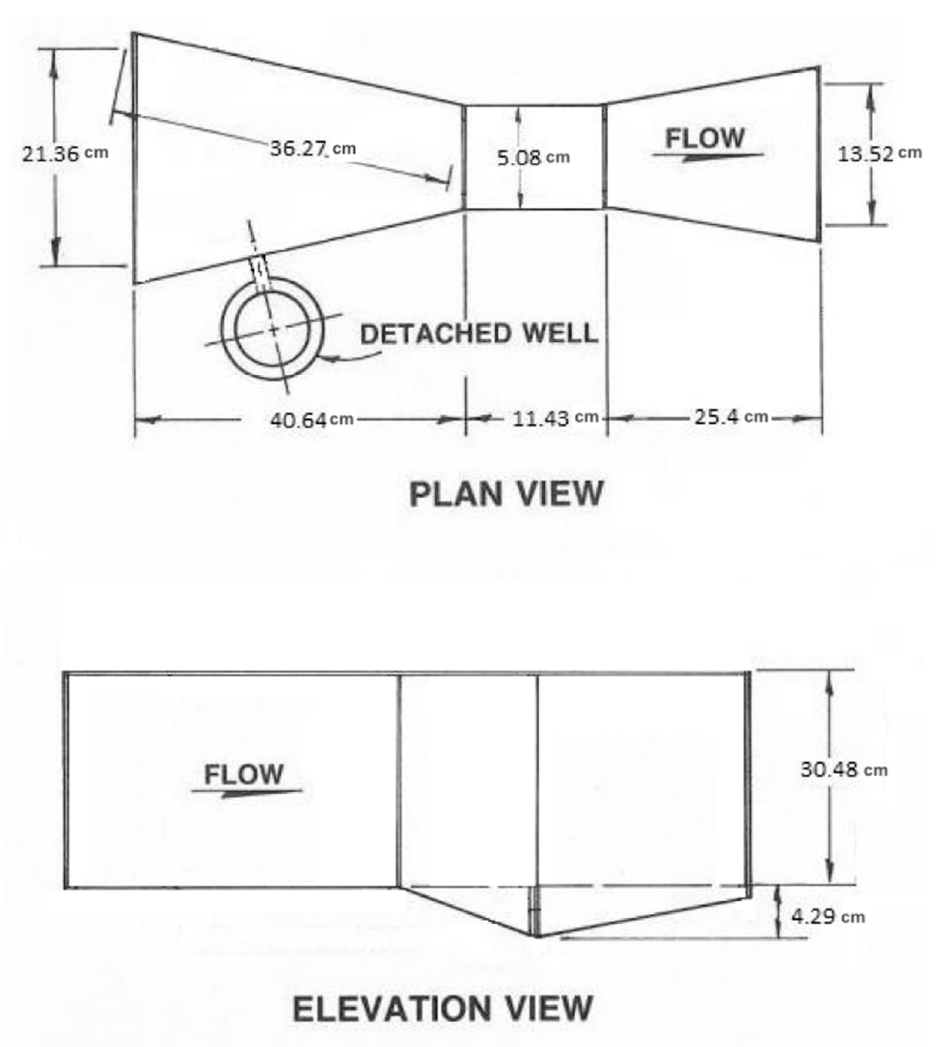
Figure 3. Parshall Flume dimensions in cm (not to scale).